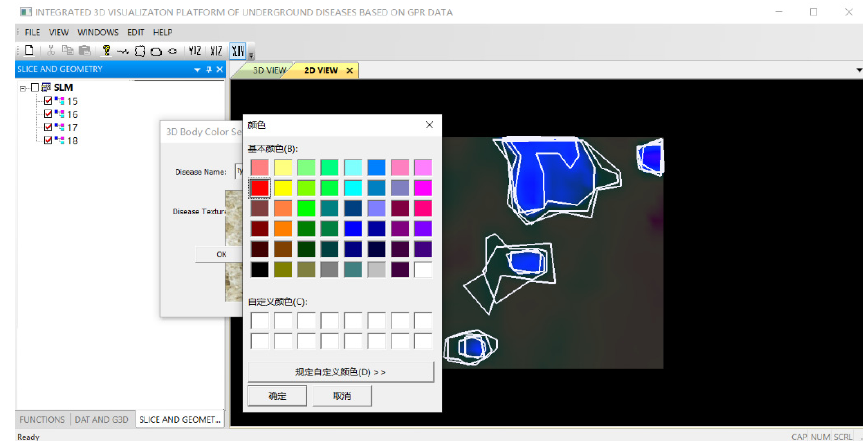
Figure 12. Configuration of attribute information.